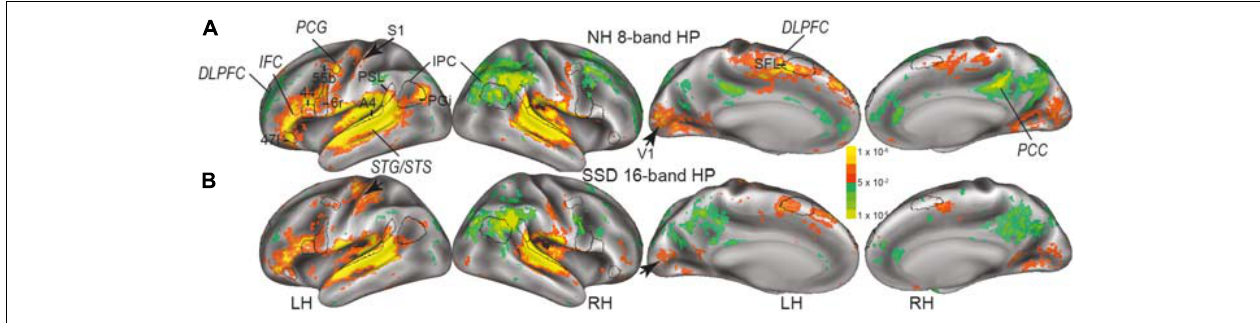
FIGURE 2 | The imaging study found bilateral cluster distributions of positive and negative BOLD. (A) Results obtained from normal hearing (NH) to 8-band sentences with predictable semantics. (B) Results obtained from single sided deafness (SSD) to 16-band sentences with predictable semantics. Cortex colored red-orange to bright yellow or blue to light green had, respectively, positive and negative BOLD signal changes. Black borders encircle a few selected parcels: DLPFC, dorsolateral prefrontal cortex; IFC, inferior frontal cortex; IPC, inferior parietal cortex; PCC, posterior cingulate cortex; PCG, precentral gyrus; STG/STS, superior temporal gyrus/sulcus. Parcels: A4, 44, 47l, 55b, 6r, PGi, PSL (perisylvian language parcel), SFL (superior frontal language), S1 (primary somatosensory cortex), V1 (primary visual cortex). LH, RH left and right hemispheres.